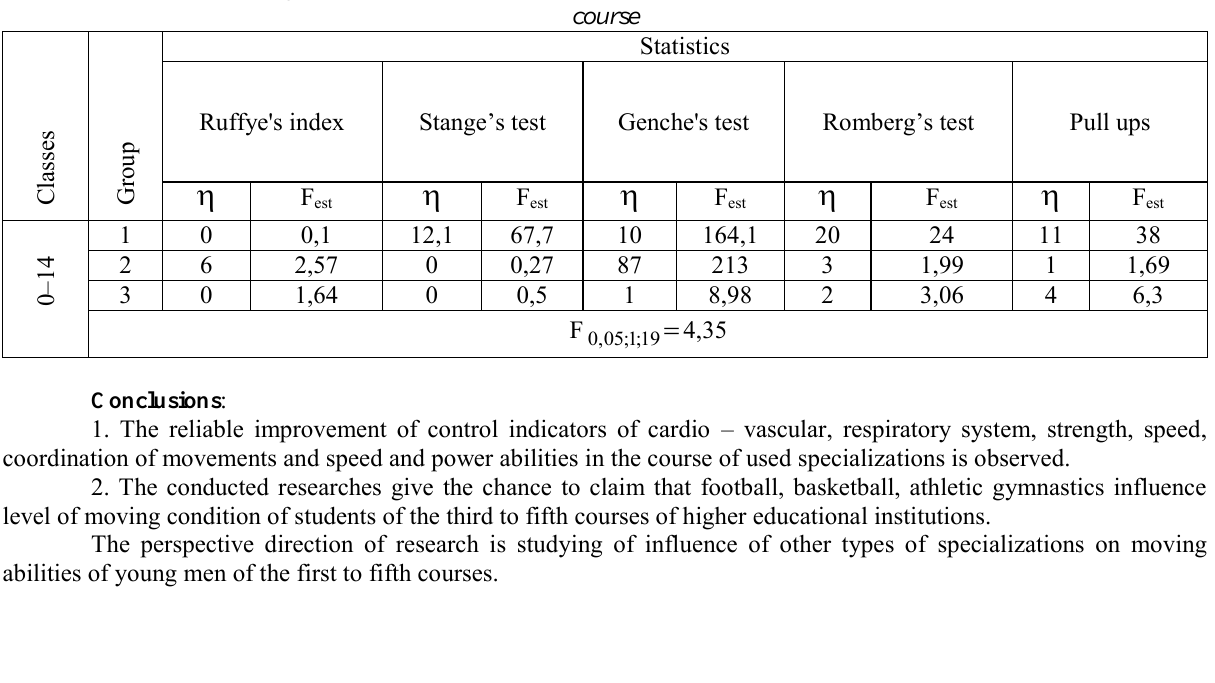
The extent of influence of specializations on results of the functional and motive tests (%) of male students of the